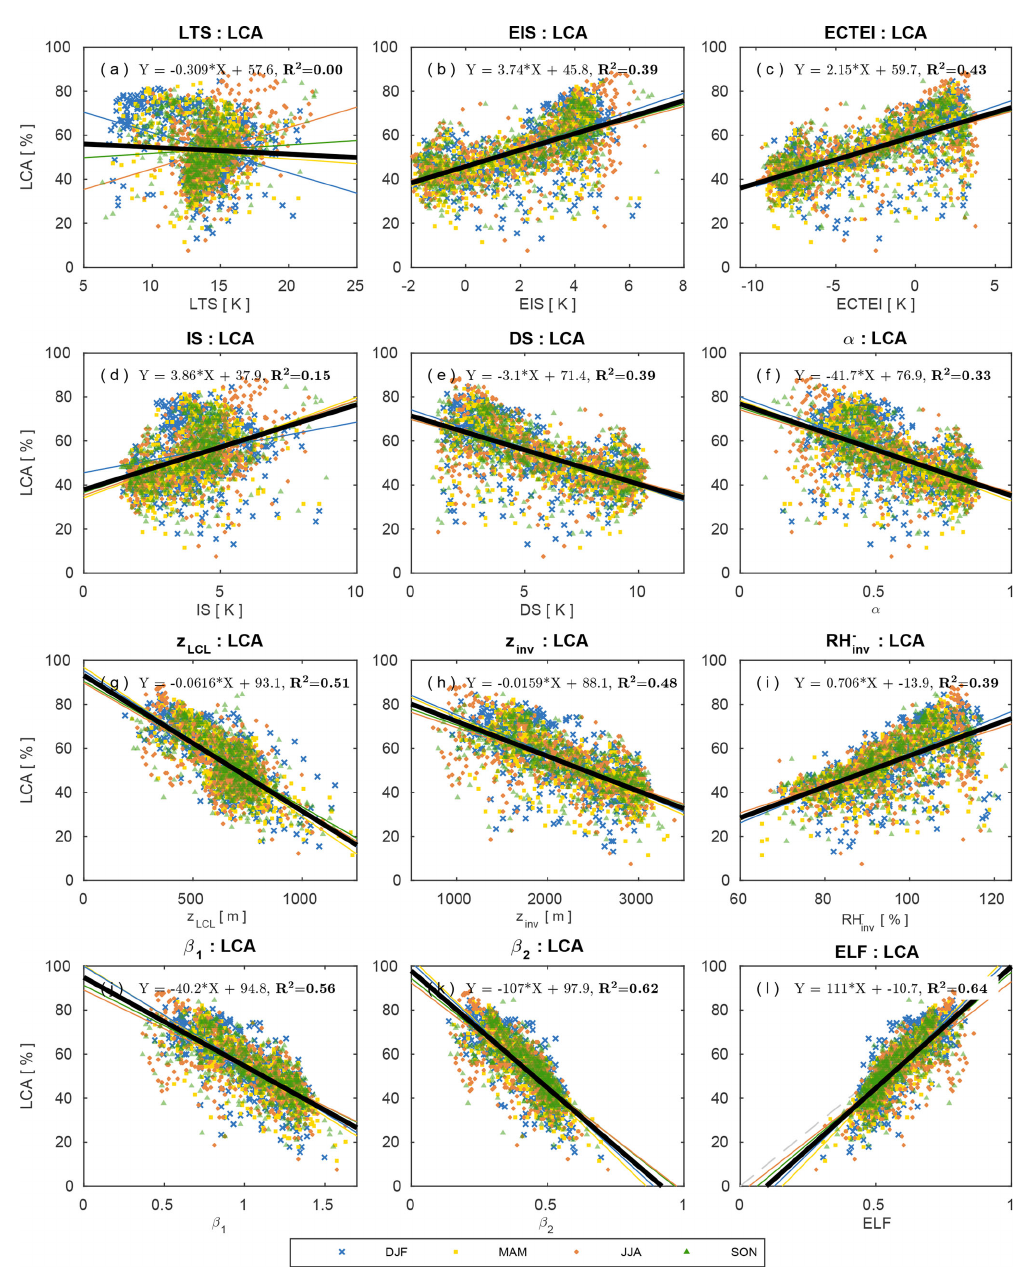
Figure 5. Scatter plots between LCA and various proxies over the ocean. Each dot reflects climatological seasonal data at each 5 ◦ lati- tude × 10 ◦ longitude grid box shown in Figs. 3 and 4, and different colors denote different seasons. Also plotted are the least-squares fitting lines for each season (colored lines) and all seasons (thick black line) and regression equations for all seasons with the corresponding fraction of variance ( R 2 ) explained by the all-seasons regression equation. The dashed gray line in (l) denotes LCA = ELF. Only the data satisfying 0 < α < 1 are used for this